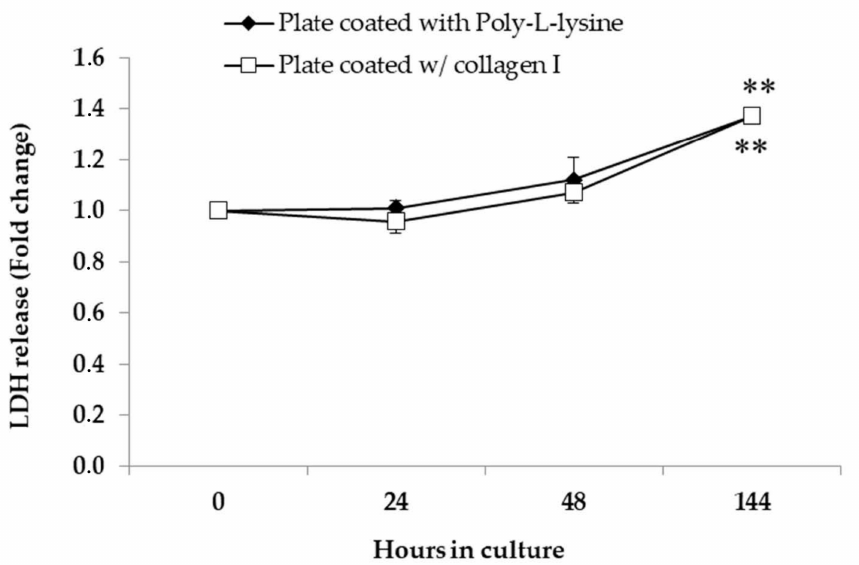
Figure 4. Lactate dehydrogenase (LDH) released by S. aurata primary hepatocytes cultured in a 24- well plate coated with poly-L-lysine and collagen I. After the overnight incubation of 10 5 cells/well, the L-15 medium was collected at 24, 48, and 144 h to assess LDH activity. A significant difference was observed between the control and T 144 ; ** p < 0.01.